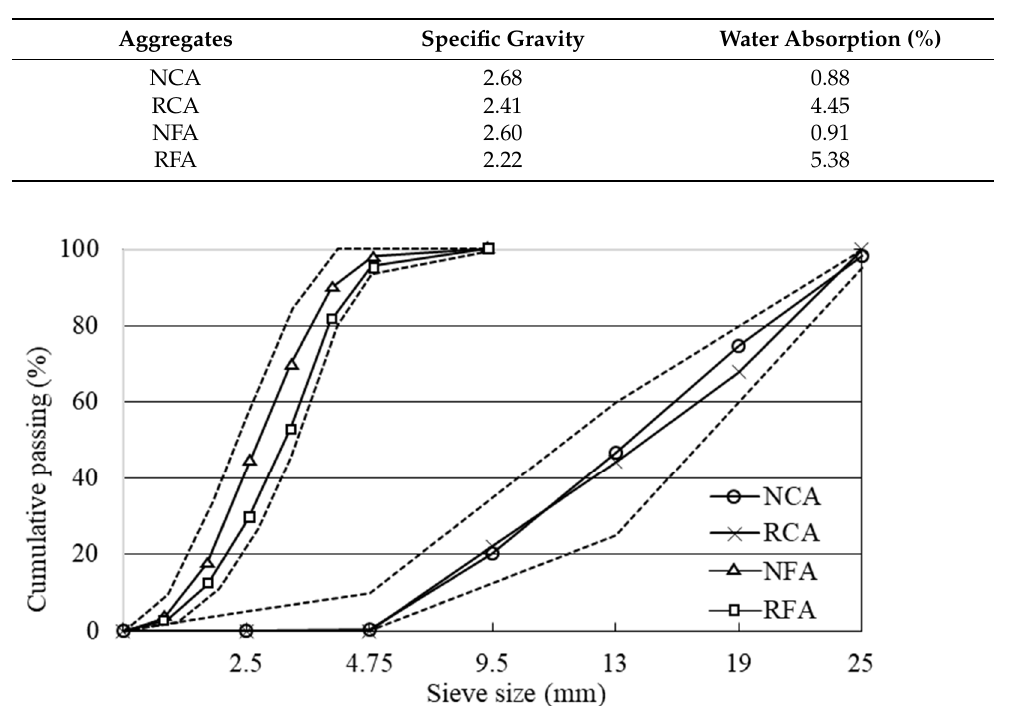
Figure 1. Particle size distribution of natural and recycled aggregates.